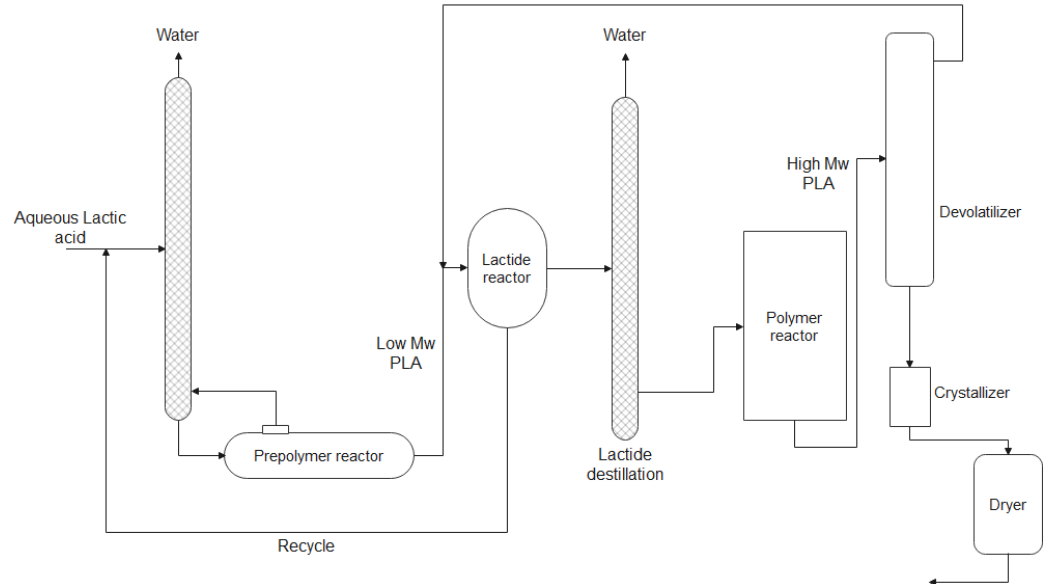
Figure 10. Industrial plant design of Natureworks TM (Cargill Dow) for the production of lactide and PLA (reprinted with permission [12], Copyright 1998 Elsevier).